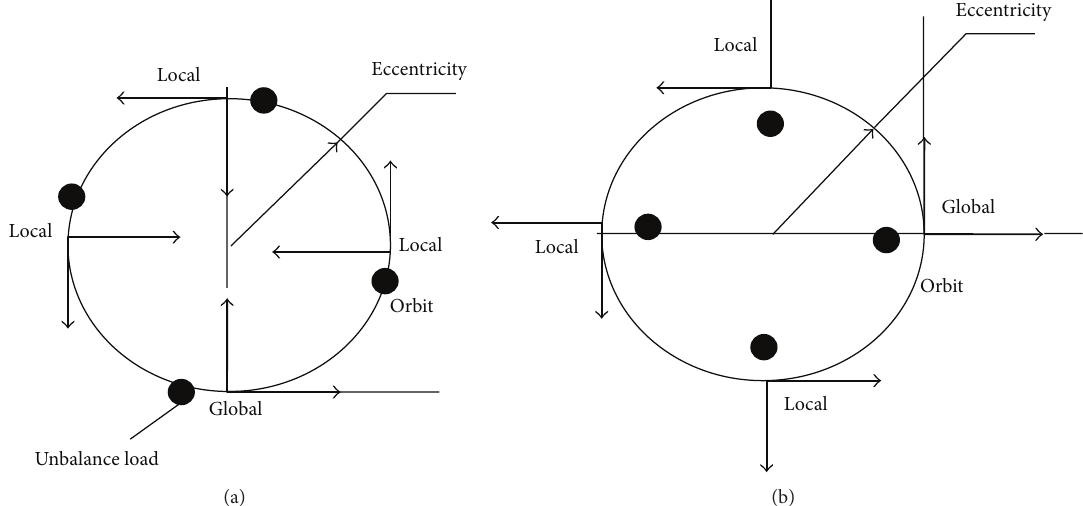
Figure 9: Schematic of orbit orientation for motion component: (a) angular velocity ( 𝜔 ), translational velocity in 𝑥 -axis ( V 𝑥 ) and (b) angular velocity ( 𝜔 ), translational velocity in 𝑦 -axis ( V 𝑦